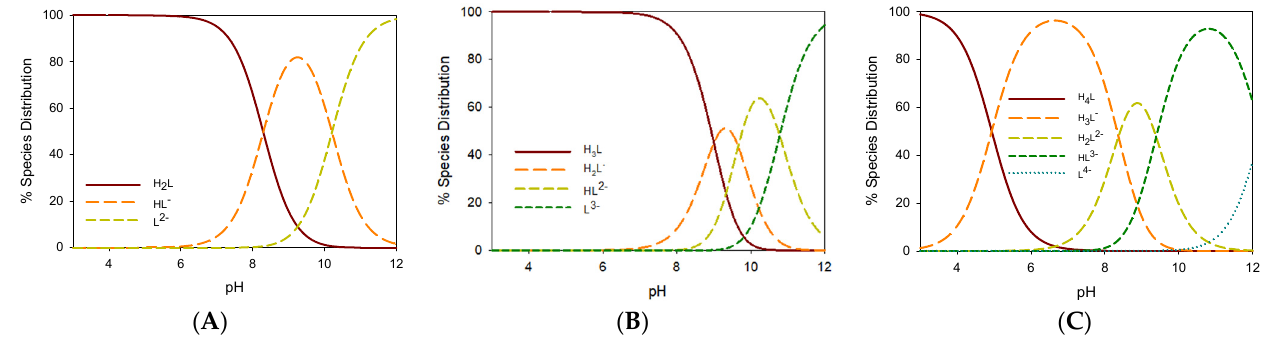
Figure 6. Species distribution curves for 1 (panel A ), 4 (panel B ) and 7 (panel C ) at 25 °C ([L] total = 10 − 4 mol L − 1 ). The data were calculated on the basis of the log β MLH values reported in Table 2.